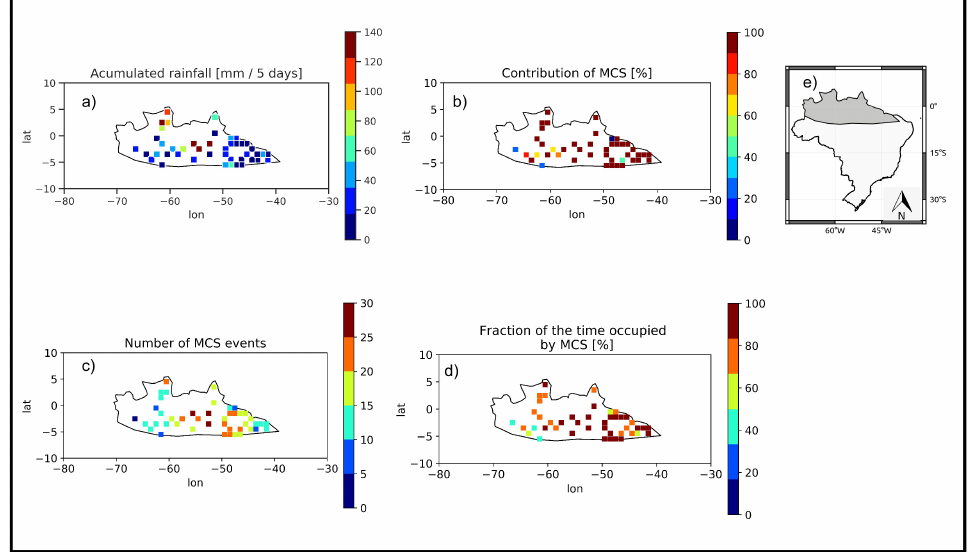
Figure 20. ( a ) Accumulated rainfall recorded during 29 April 2016 to 3 May 2016 over north Brazil (R5); ( b ) fraction of rain on days that had MCS records over the rain accumulated in five days; ( c ) number of MCS events recorded in five days; ( d ) fraction of the days that had MCS records; ( e ) analyzed